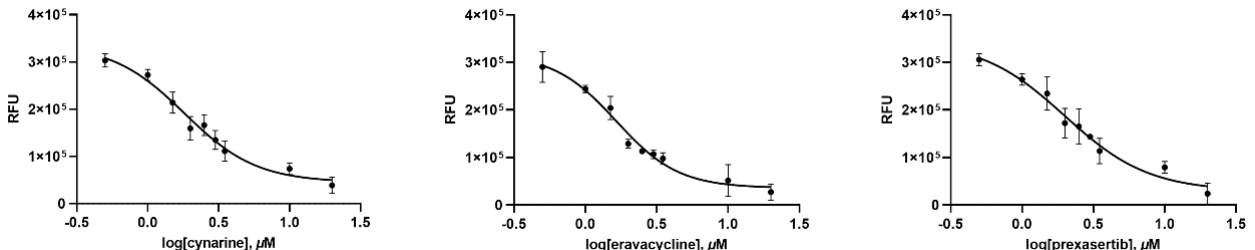
Figure 1. Inhibition of SARS-CoV-2 3CLpro. Each data point represents the effect of each inhibitory compound against SARS-CoV-2 3CLpro compared with the control. The RFU are plotted against the log-concentration of inhibitory compounds. Each dot is expressed as the mean ± standard error of the mean ( n = 3). RFU = relative fluorescence units.